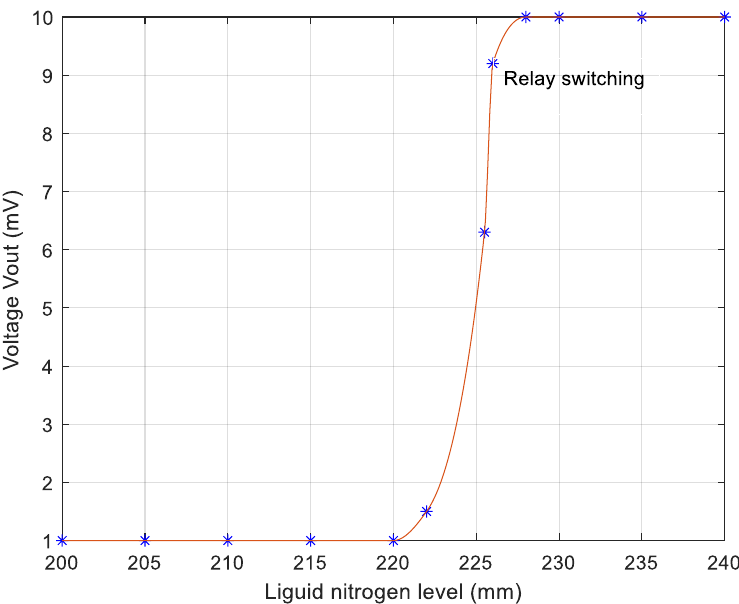
Figure 7. Liquid nitrogen level transducer: experimental data (stars) and theoretical results (solid line).